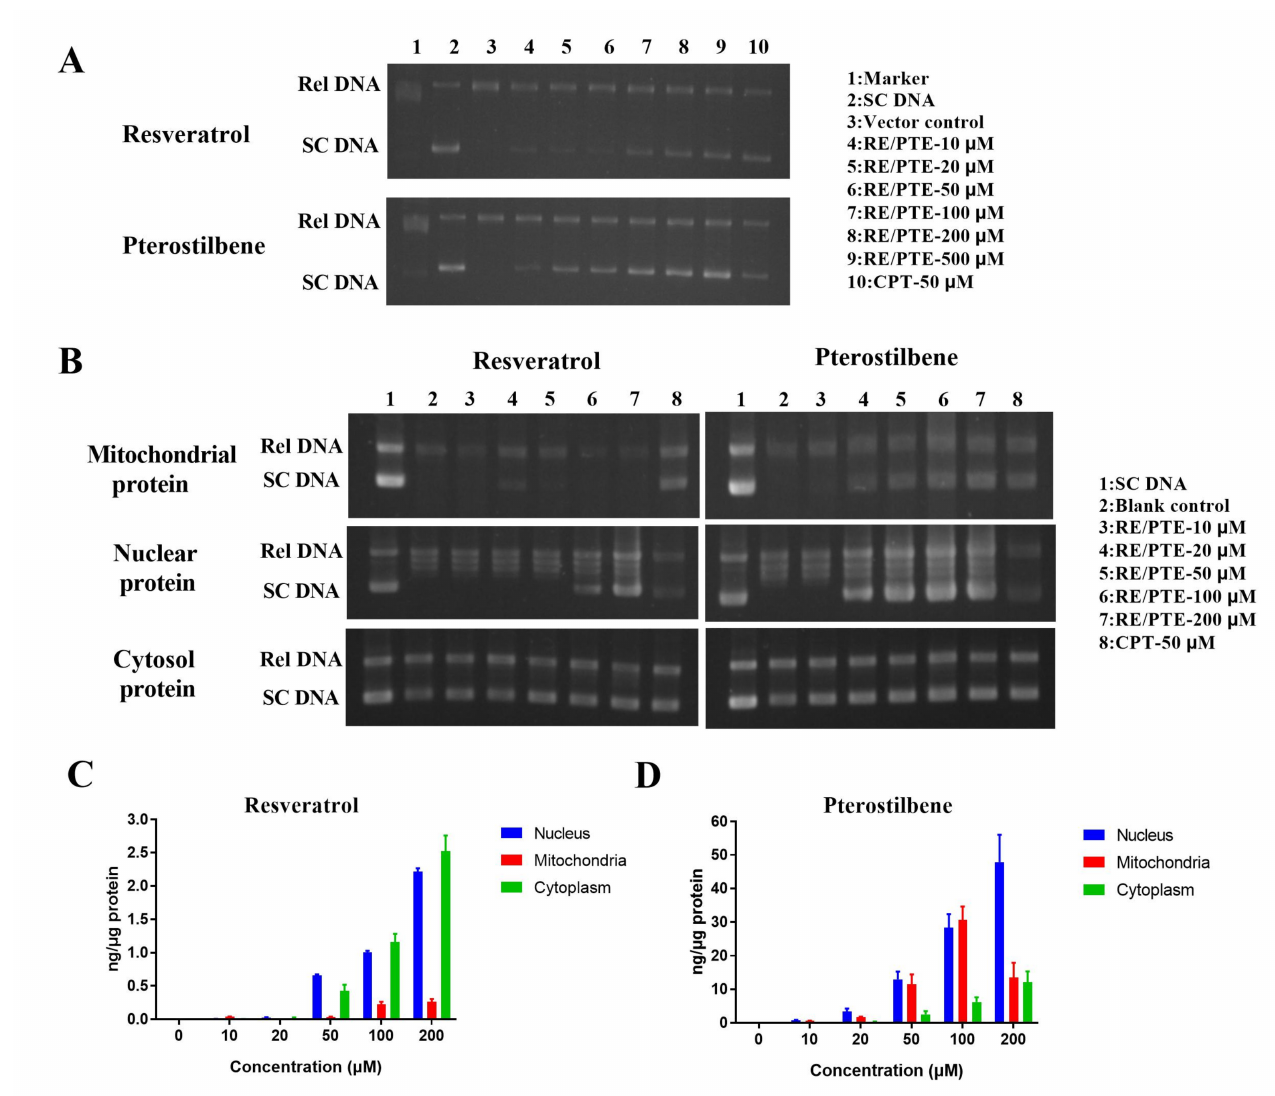
Figure 4. Effects of PTE and RE on Top1 relaxation activity. ( A ) Effects of PTE and RE at the different concentrations on Top1 relaxation activity. Lane 1, DNA marker; Lane 2, supercoiled plasmid DNA (pHOT-1, SC DNA); Lane 3, SC DNA+Top1; Lanes 4–9, SC DNA+Top1+RE/PTE; Lane 10, SC DNA+Top1+CPT. ( B ) Lane 1, SC DNA; Lane 2, SC DNA+ extract of CL 187 cells; Lanes 3–8, SC DNA+ extract of CL 187 cells treated with RE or PTE. Distribution of RE ( C ) and PTE ( D ) in CL 187 cells. Data are mean ± SD, n =